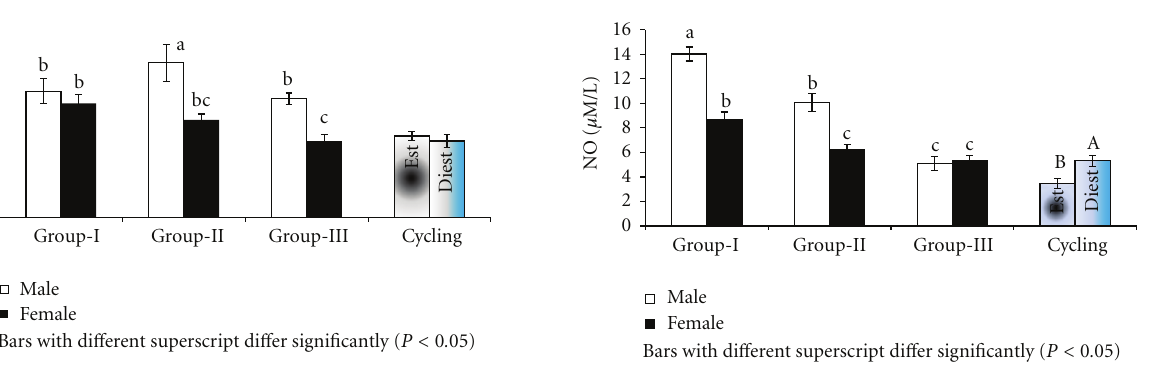
day 0 (3 . 98 ± 0 . 40 μ M/L) (Figure 4). There was